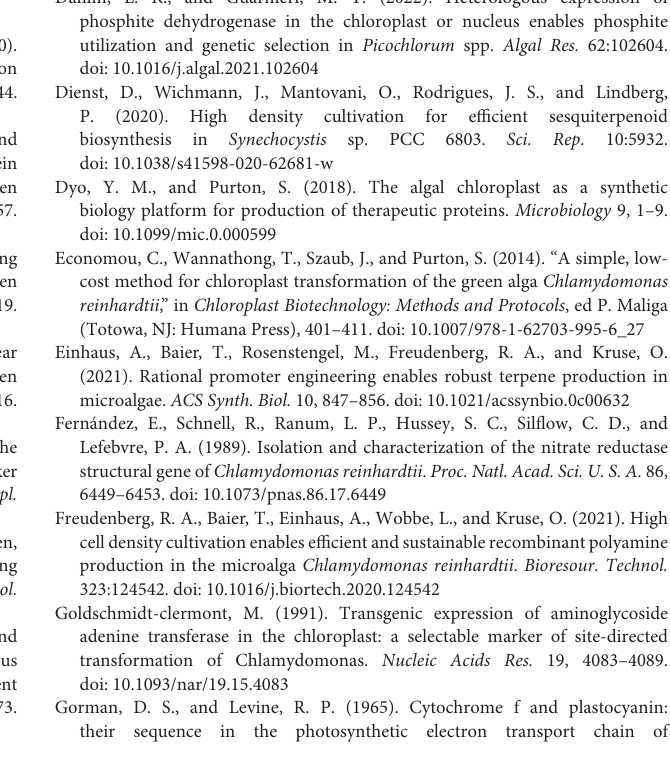
TAAAATTGTGAGACCATGAGTAATGTTCCTCC were used to perform PCR on DNA extracts from each strain. The target region without amplification should yield the 1,050-bp band, while integration should yield 3,075-bp products. Supplementary Figure 4 | In gel fluorescence of SDS PAGE samples from one representative mutant of each of the genetic constructs indicated. Fluorescence image was captured with 510/10-nm excitation and 530/10-nm emission filter in the AnalytikJena Chemstudio Plus with eLite. White-contrast, black-and-white image was taken without emission filter using 510/10-nm excitation to visualize the marker. Supplementary Figure 5 | Patchoulol productivities observed in dodecane overlays for six transformants selected for bright YFP fluorescence from each of the above plasmids and compared to parental UPN strain and empty vector (Y)-generated control strains. Numbers at the bottom of the graph correspond to the plasmid name and the mutant number (1.1 = 1X Pc PS, transformant #1). Each mutant was analyzed in technical triplicates. Productivity-grouped averages are shown on the left and labeled with each plasmid name. Horizontal bars show the mean, while vertical bars show the range of values. Supplementary Figure 6 | Patchoulol productivities observed in dodecane overlays for six transformants isolated from secondary transformation of the best 1-4X Pc PS strains with c CA_ g Luc_i3_SQSk.d. plasmid (Wichmann et al., 2018). Upper right: representitive GC-MS chromatograms showing the drastic increase of patchoulol production in SQS k.d. secondary transformants relative to alpha-humulene internal standard. Lower graphs: Numbers at the bottom of the graph correspond to the plasmid name and the mutant number (1 x 1 = 1 X Pc PS SQS k.d. mutant 1). The averages of all transformants per group are shown on the left and labeled with each plasmid name. Corresponding parent performances are also shown from the data in the previous figure. Supplementary Table 1 | Genetic constructs used in this study. Plasmids for transformation of C. reinhardtii are shown as well as some of their respective properties. References to plasmid sequences are given, and those generated in this work are provided in the